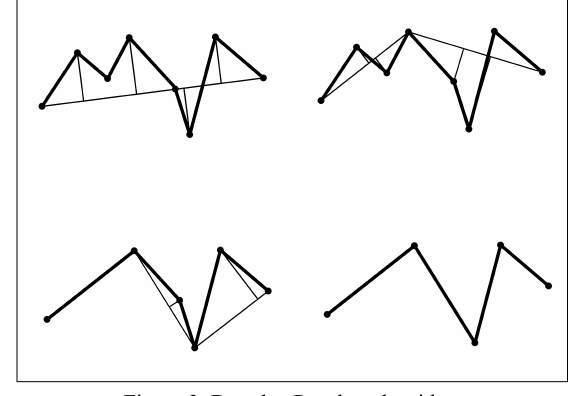
Figure 3. Douglas-Peucker algorithm